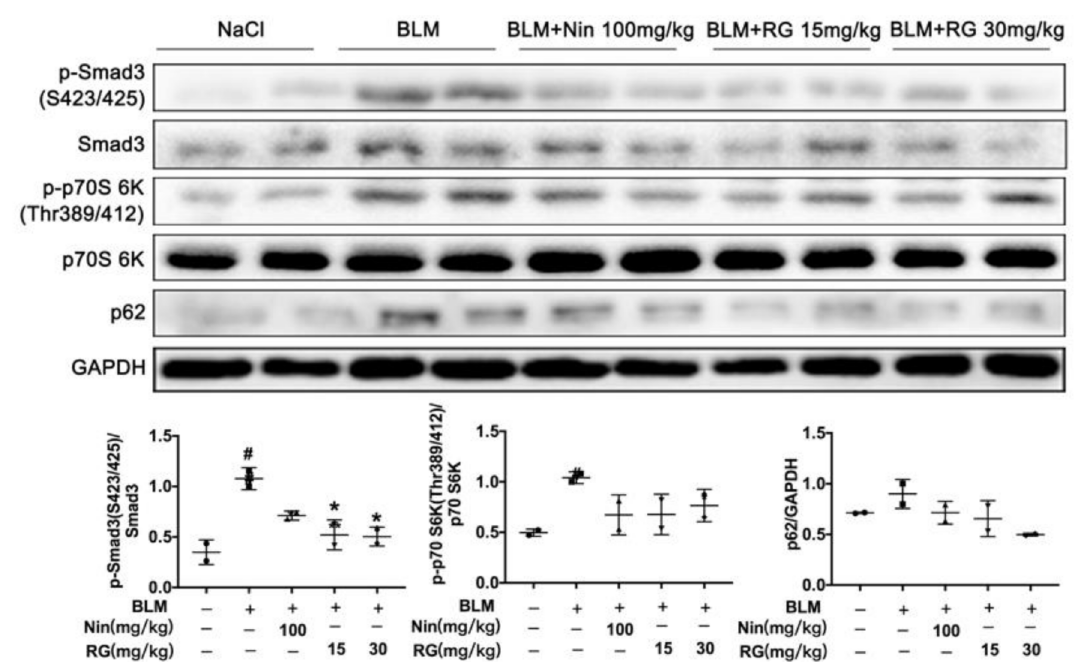
Figure 6. RG promotes autophagy formation and inhibits TGF- β 1/mTOR signaling in vivo. The mice were orally treated with RG (15 mg/kg, 30 mg/kg) from day 7 to day 13 after BLM administration, and lung homogenization was used to analyze the expression levels of p-Smad3 (Ser423/Ser425), p-p70 S6K (Thr389/412), and p62 by Western blotting. Densitometric analysis is shown. # p < 0.05, * p < 0.05 (one-way ANOVA), NS: not